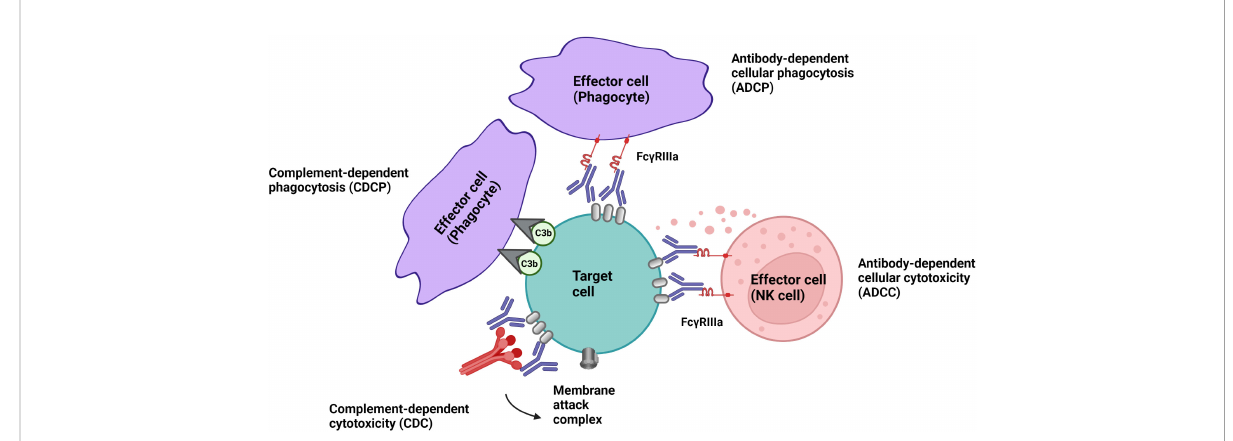
FIGURE 1 Effector mechanism of cell-depleting therapeutic IgG antibodies in MS. Complement-dependent cytotoxicity (CDC) is triggered through binding of C1q, which initiates activation of the classical complement pathway. Signalling through activating Fc receptors (Fc g Rs) expressed by innate immune cells such as natural killer cells and phagocytes initiates antibody-dependent cellular cytotoxicity (ADCC) and antibody-dependent phagocytosis (ADCP). Membrane-bound complement cleavage products such as C3b can additionally function as opsonins by interacting with complement receptors on effector cells which can result in complement-dependent cellular phagocytosis (CDCP).